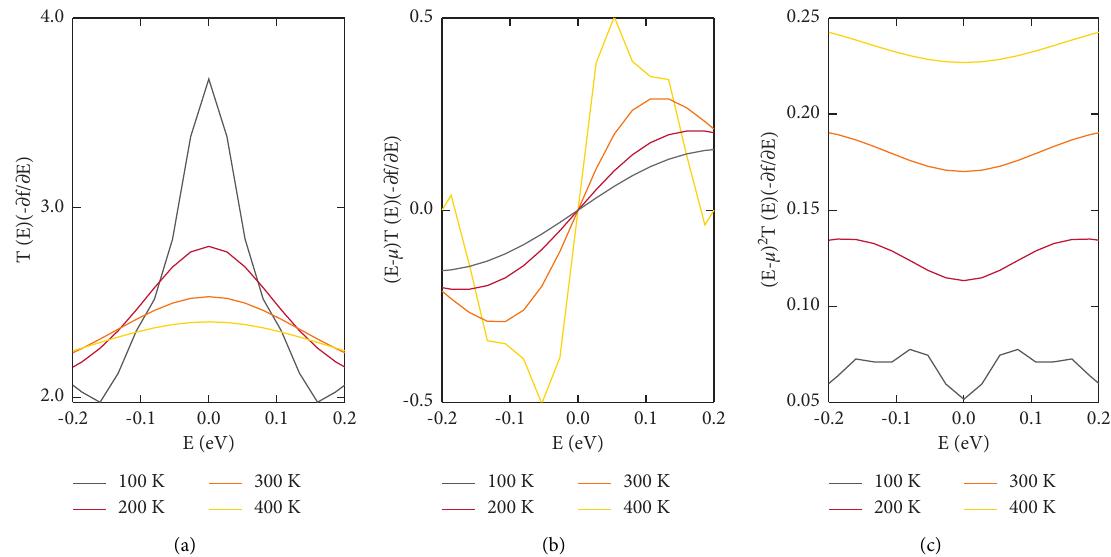
Figure 4: Temperature dependency of Lorenz functions is exemplary shown for the unperturbed ZGNR system. (a) T ( ε )(− z f / z ε ) . (b) ( ε − μ ) T ( ε )(− z f / z ε ) . (c) ( ε − μ ) 2 T ( ε )(− z f / z ε )